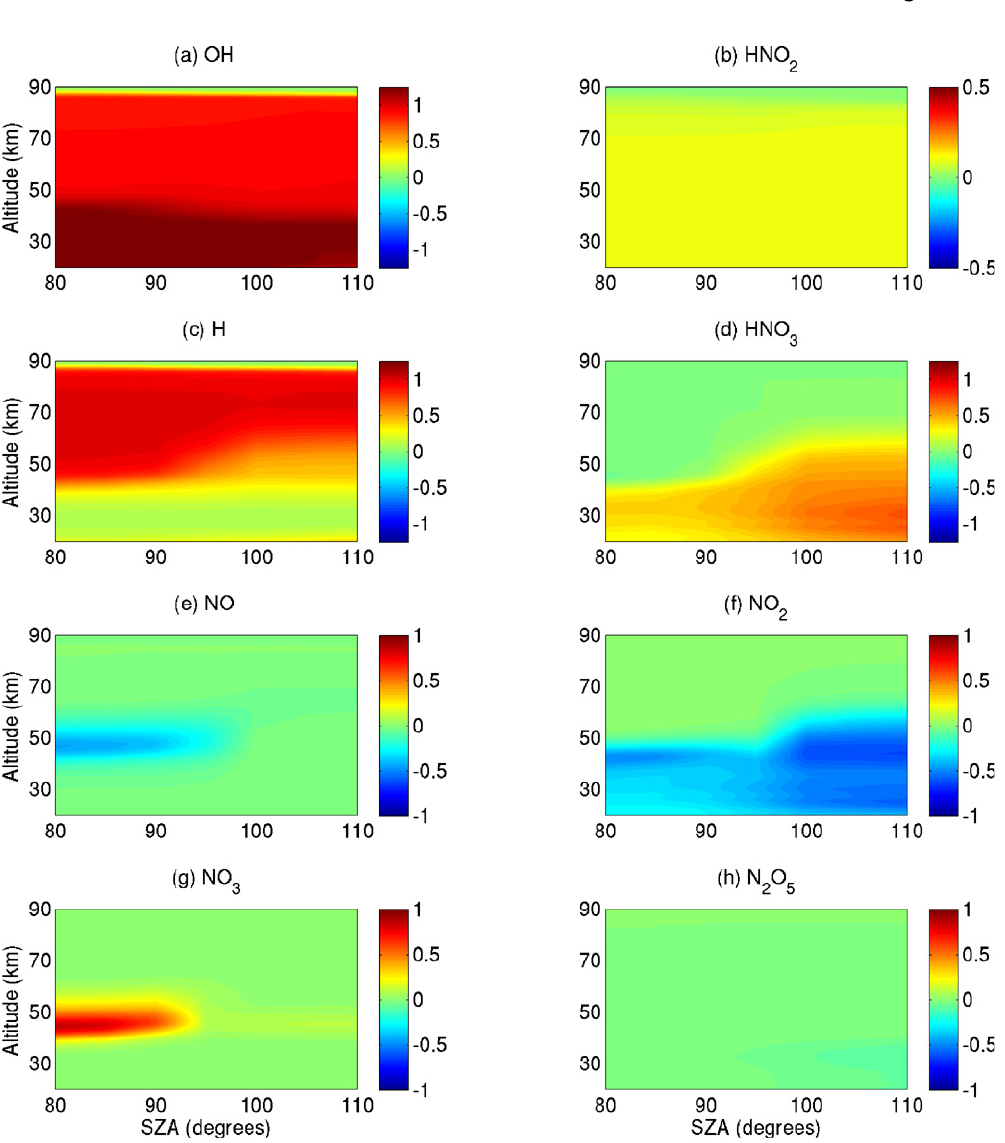
Fig. 4. As Fig. 2, but Southern